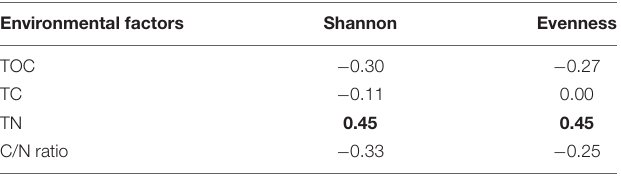
TABLE 1 | Correlation between cryoconite community Shannon and Evenness indices and environmental